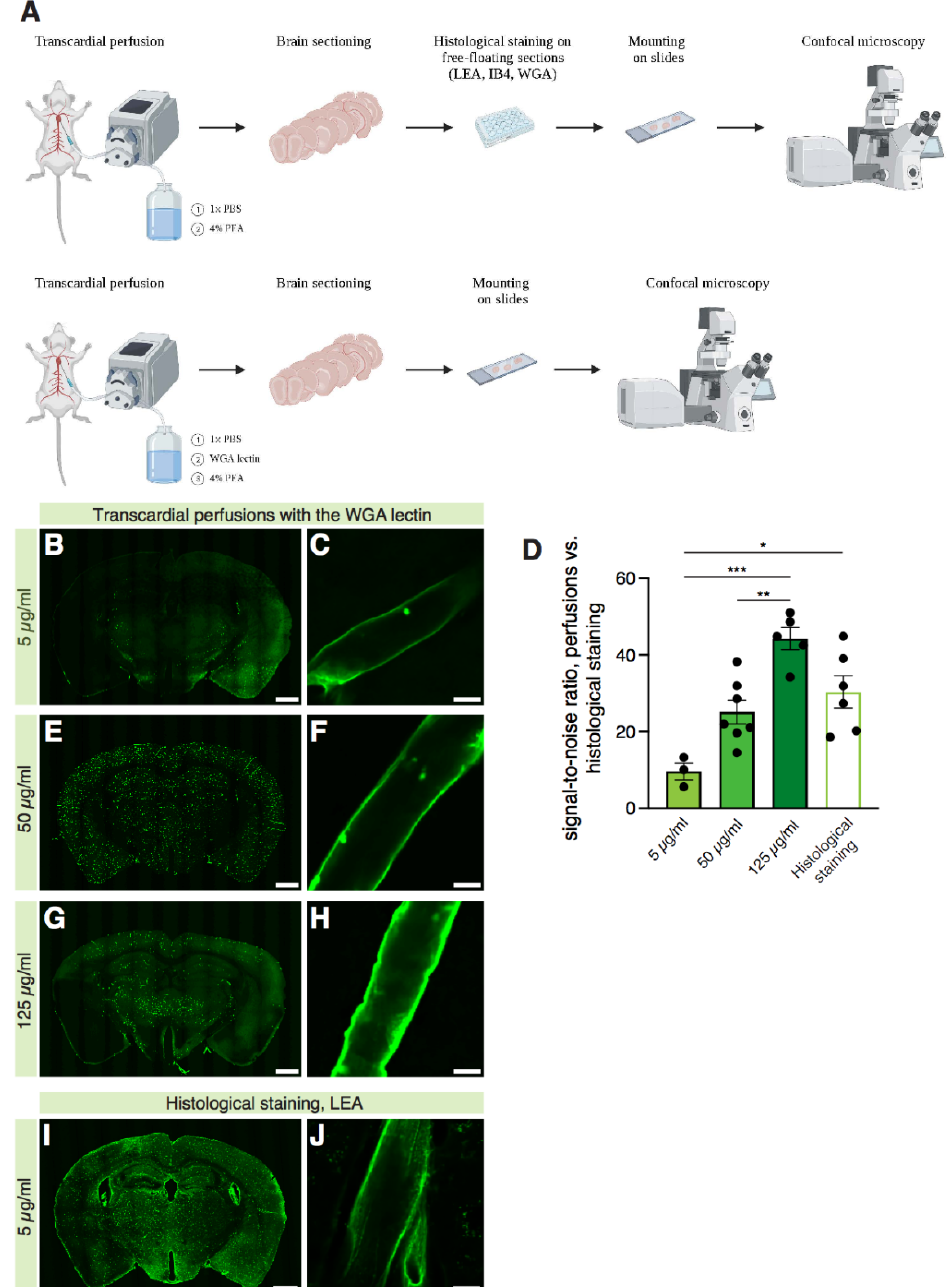
Figure 2. Comparison of different methods to labeling brain vessels with lectins: intravascular WGA delivery during terminal perfusion vs. LEA histological staining on free-floating sections. ( A ) Schematic drawing summarizing the setup for the experiments comparing the two methods. Created with BioRender. ( B – J ) Representative 10 × confocal images of brain sections of the mice intracardially perfused with the WGA lectin at a concentration of 5 µ g/mL ( B ), 50 µ g/mL ( E ), and 125 µ g/mL ( G ) compared to the ones histologically stained with the LEA lectin ( I ) and ( D ) quantification of the signal-to-noise ratio of the vessels stained with different methods (representative confocal 20 × -magnified images in C , F , H , J ). Three vessels analyzed per animal; n = 3 mice for the 5 µ g/mL group, n = 7 mice for the 50 µ g/mL group, n = 5 mice for the 125 µ g/mL group, n = 6 mice for the LEA histological staining group (one-way ANOVA test, p = 0.0002; Tukey’s multiple comparisons test: 5 µ g/mL WGA vs. 125 µ g/mL WGA, p = 0.0001; 5 µ g/mL WGA vs. LEA, p = 0.0112; 50 µ g/mL WGA vs. 125 µ g/mL WGA, p = 0.0047). * = p < 0.05; ** = p < 0.01; *** = p < 0.001. Scale bars: 1000 µ m for low-magnification images, 10 µ m for high-magnification images.